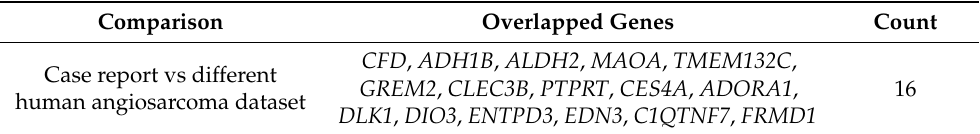
Figure 7. Venn diagram of the genes that overlap in the expression signatures of the two datasets studied.